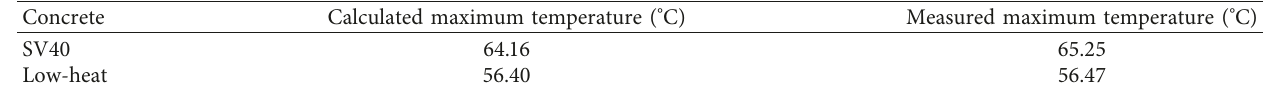
Figure 11: Calculated and measured temperatures in the middle section (low-heat concrete). Table 5: Maximum temperature in